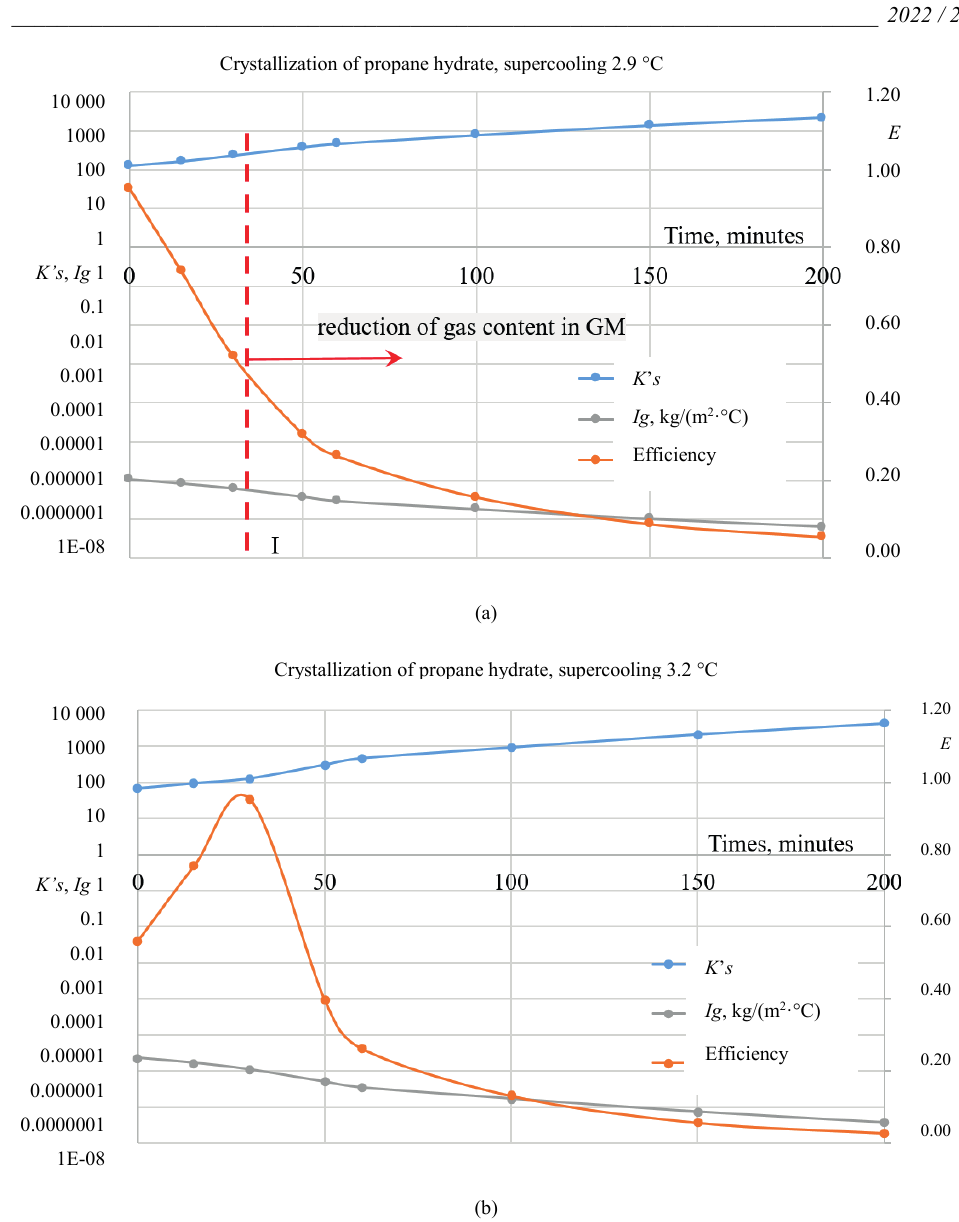
Fig. 9. Optimal characteristics of GH synthesis process at various levels of gas subcooling: (a) – 2.9 ° С; (b) – 3.2 ° С . Thus, compliance with optimal K ’ S values and renewal of the interface ensure the best intensity of hydrate formation. According to our technology (Fig. 1), additional gas cooling (if necessary) is performed in thermostat 8 and thus K ’ S value can be adjusted. This criterion for optimization of heat and mass transfer processes in GM synthesis on the interfacial surface allows to determine the process parameters, complying with the above requirements to increase the intensity of the hydrate formation process. The proposed criterion can be applied to the GM bubbler